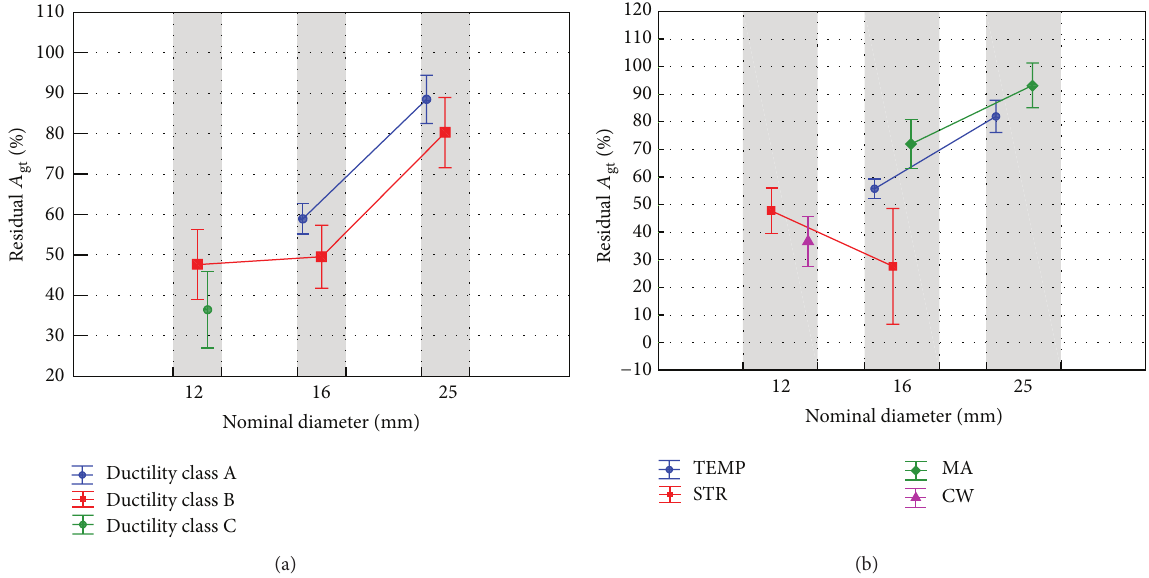
Figure 13: Influence of (a) ductility class and nominal diameter and (b) production type and nominal diameter on residual 𝐴